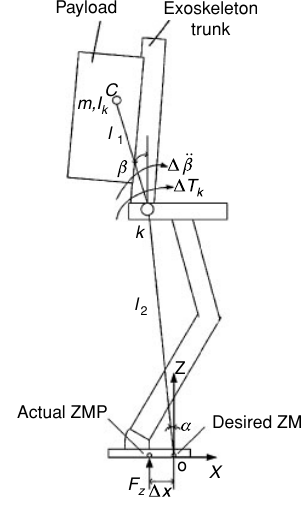
Figure 8 Adjusting ZMP by trunk